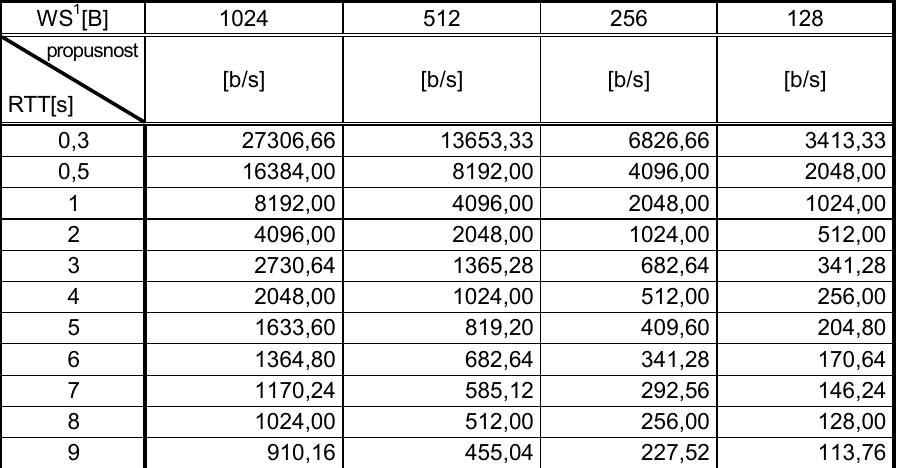
Tabela 1 – Podaci za gornje granice vrednosti propusnosti TCP protokola u zavisnosti od vremena povratnog puta za razli č ite veli č ine prozora Table 1 – The uper limit values for the TCP protocol versus the round trip time for various window